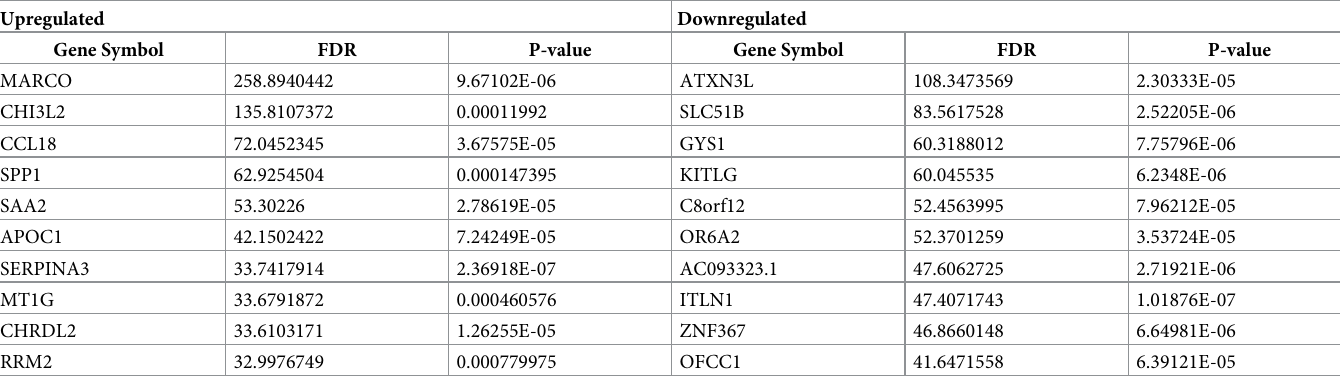
Table 1. The top ten up- and downregulated mRNAs. Upregulated